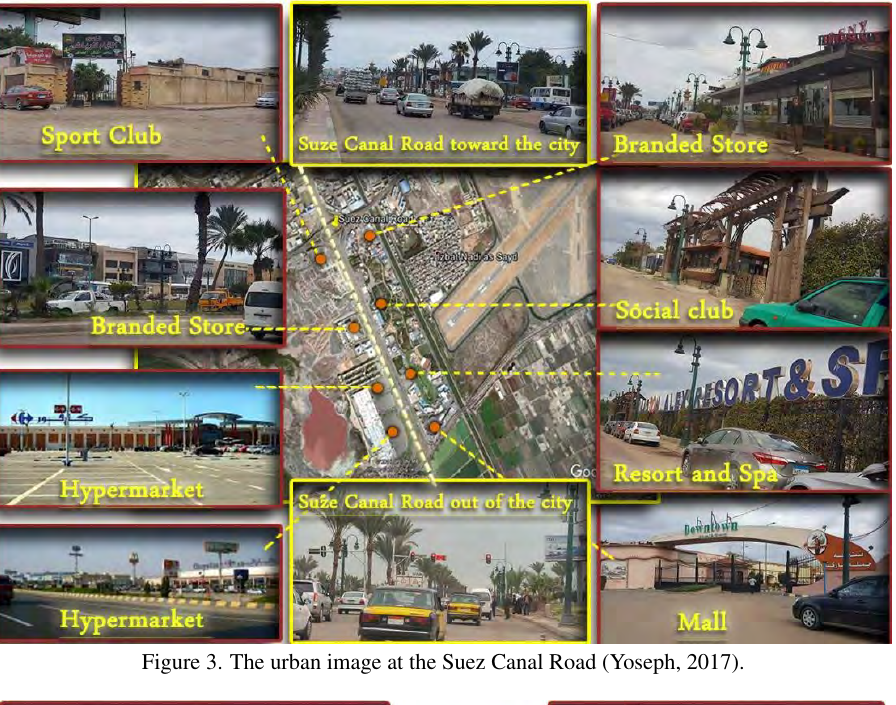
Figure 3. The urban image at the Suez Canal Road (Yoseph, 2017).